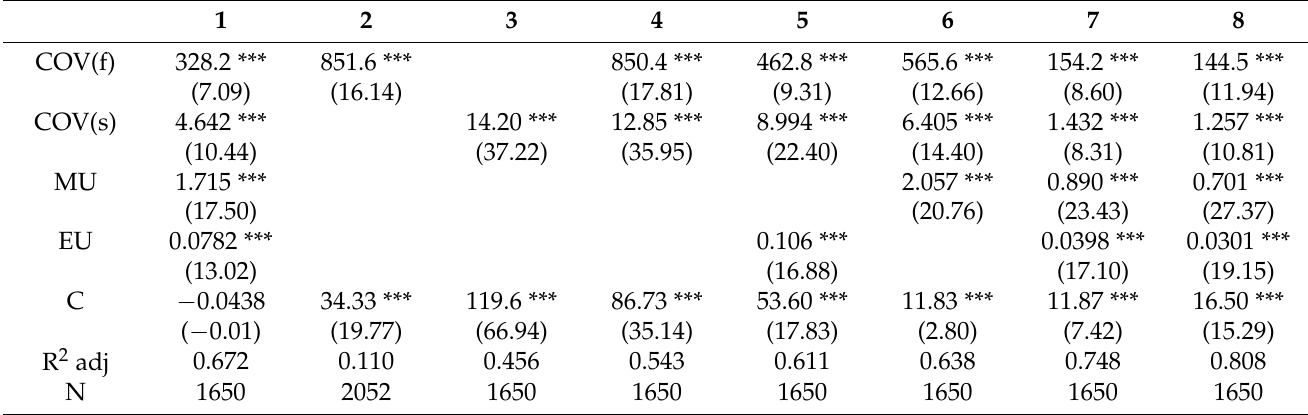
Table 11. COVID-19 death announcements, 3-week speed, and oil price volatility, world panel data.